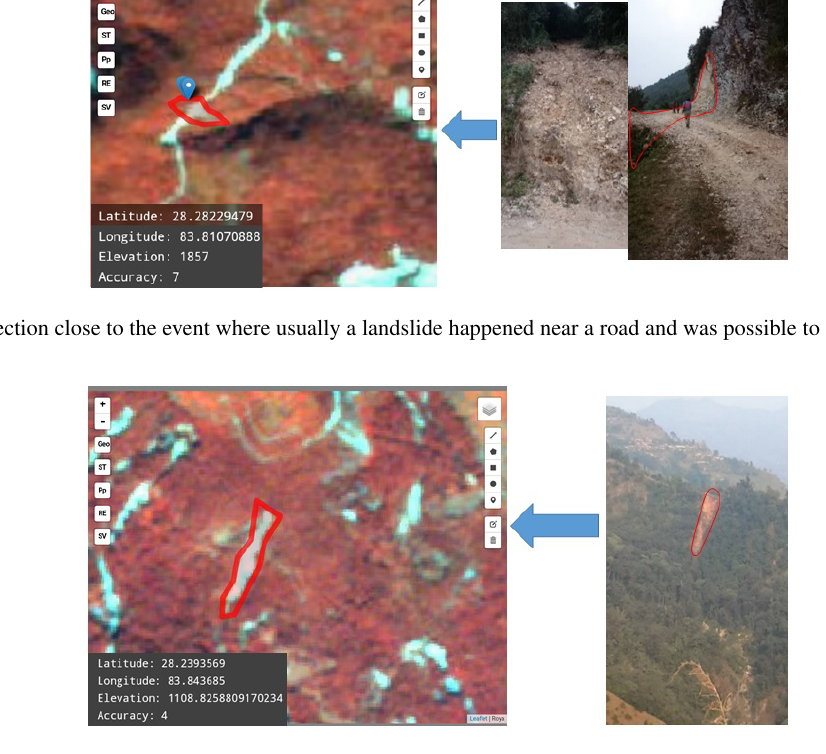
Figure 12. Data collection from a distance where access was difficult but location was easy on the map using geolocation and satellite imagery.